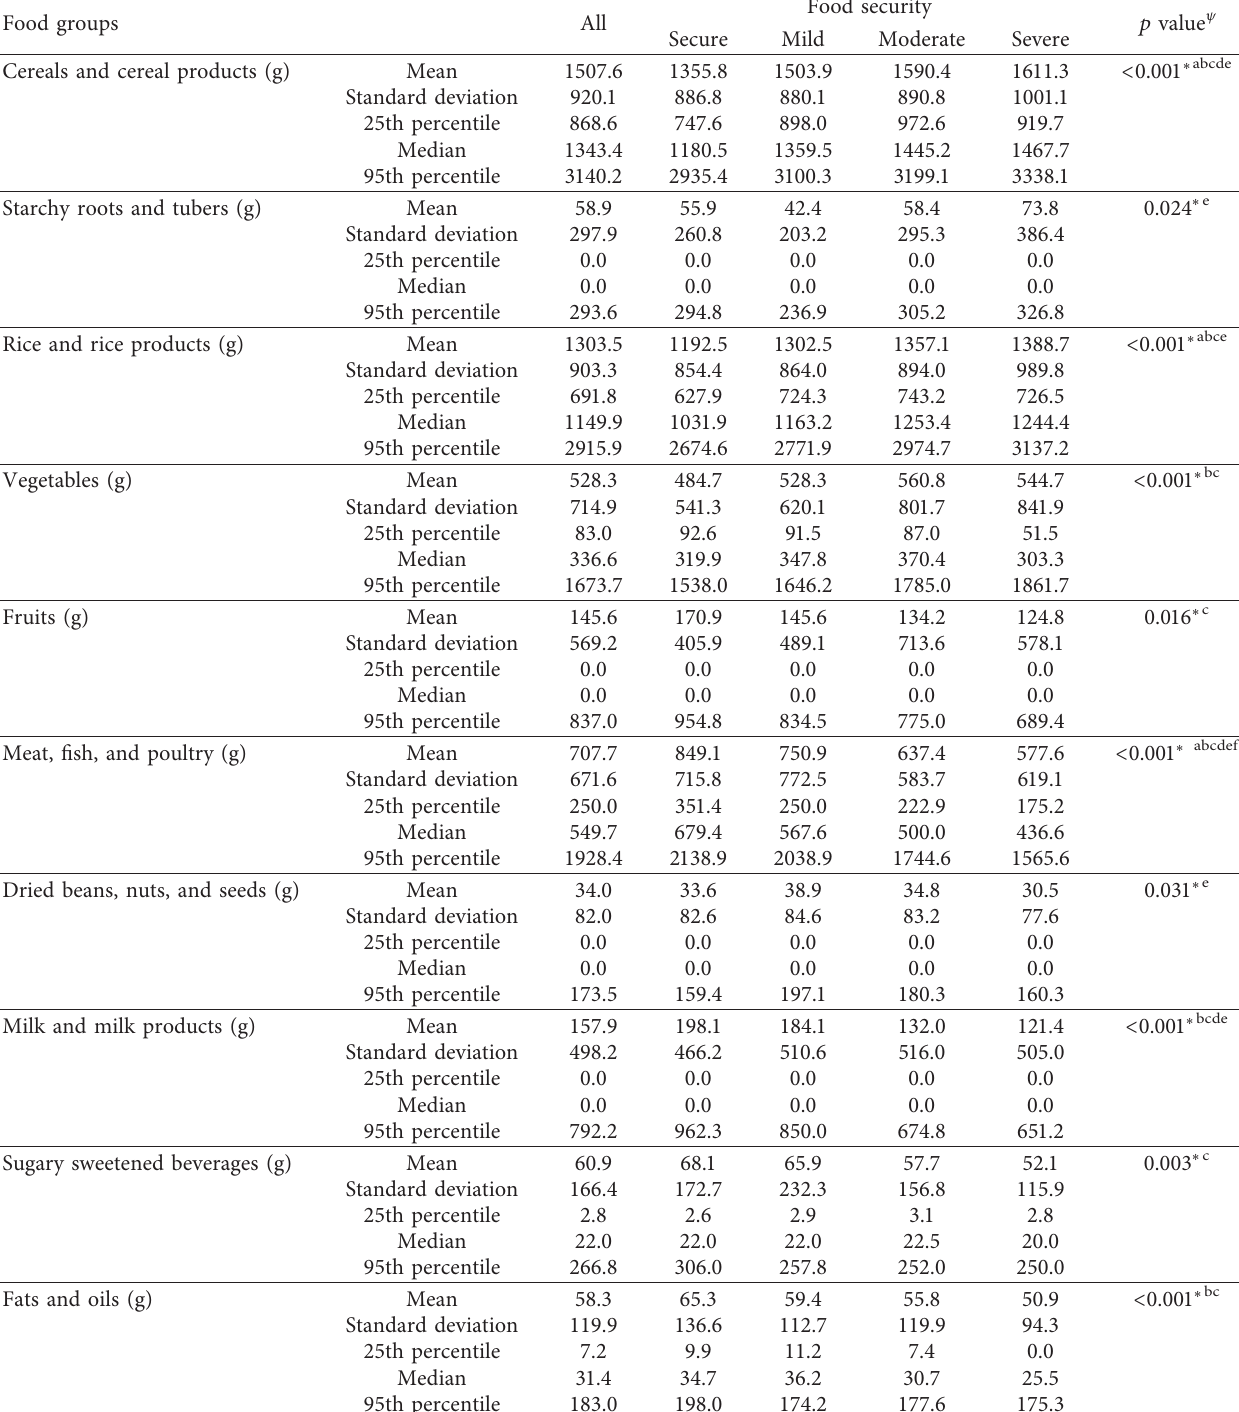
Table 6: Distribution of household total food consumption by the food insecurity level. Food